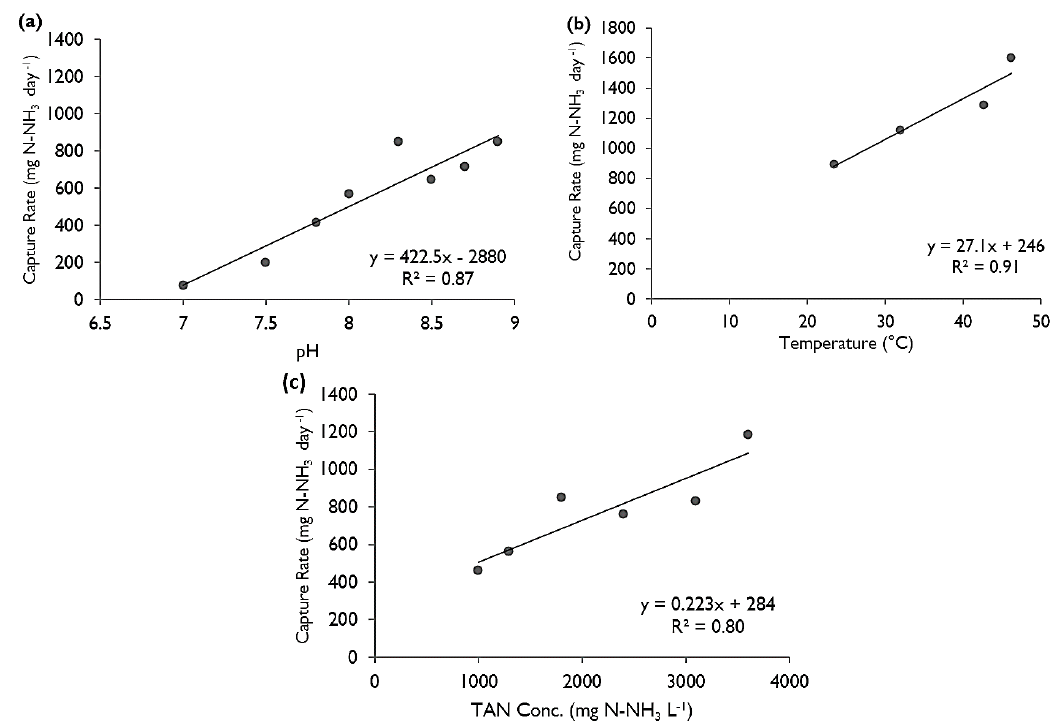
Figure 3. Comparison of the trapping rates achieved by altering ( a ) the pH, ( b ) the temperature, and ( c ) the concentration of ammonium chloride solution. The baseline parameters, i.e., those unchanged, were room temperature, 21–24 °C, 1800 mg N-NH 3 L − 1 , and pH 8.3. Flux can be determined by dividing the daily capture rate by the surface area of the gas permeable membranes (GPM). All three regressions are statistically significant, p < 0.05.